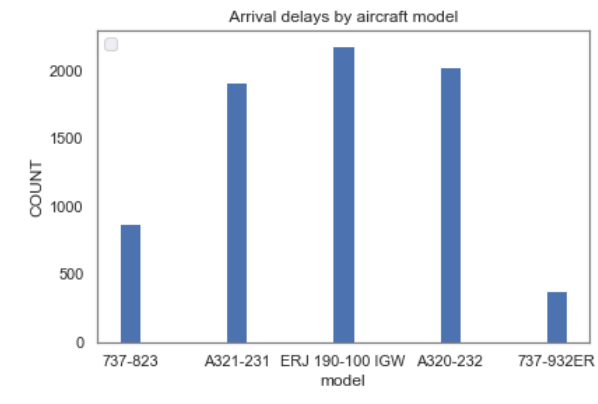
Fig. 5. Arrival delay by model of aircraft